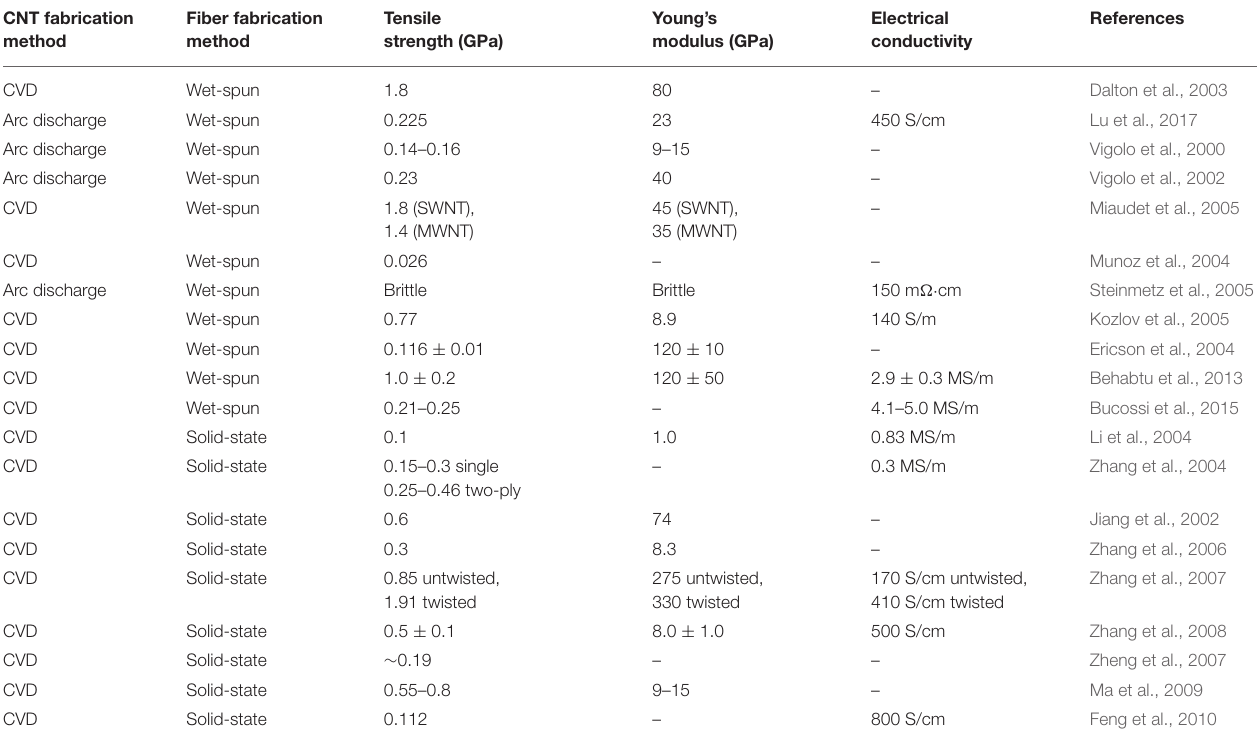
TABLE 1 | Properties of carbon nanotubes in fiber formation for wearable